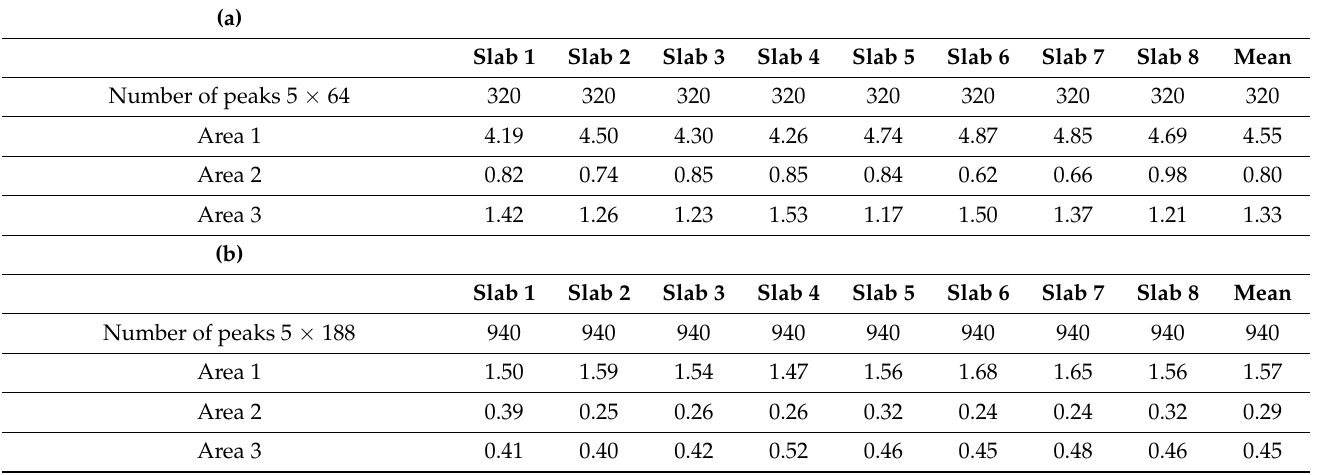
Table 4. Statistical result based on normalized peak for IE signals collected from defect